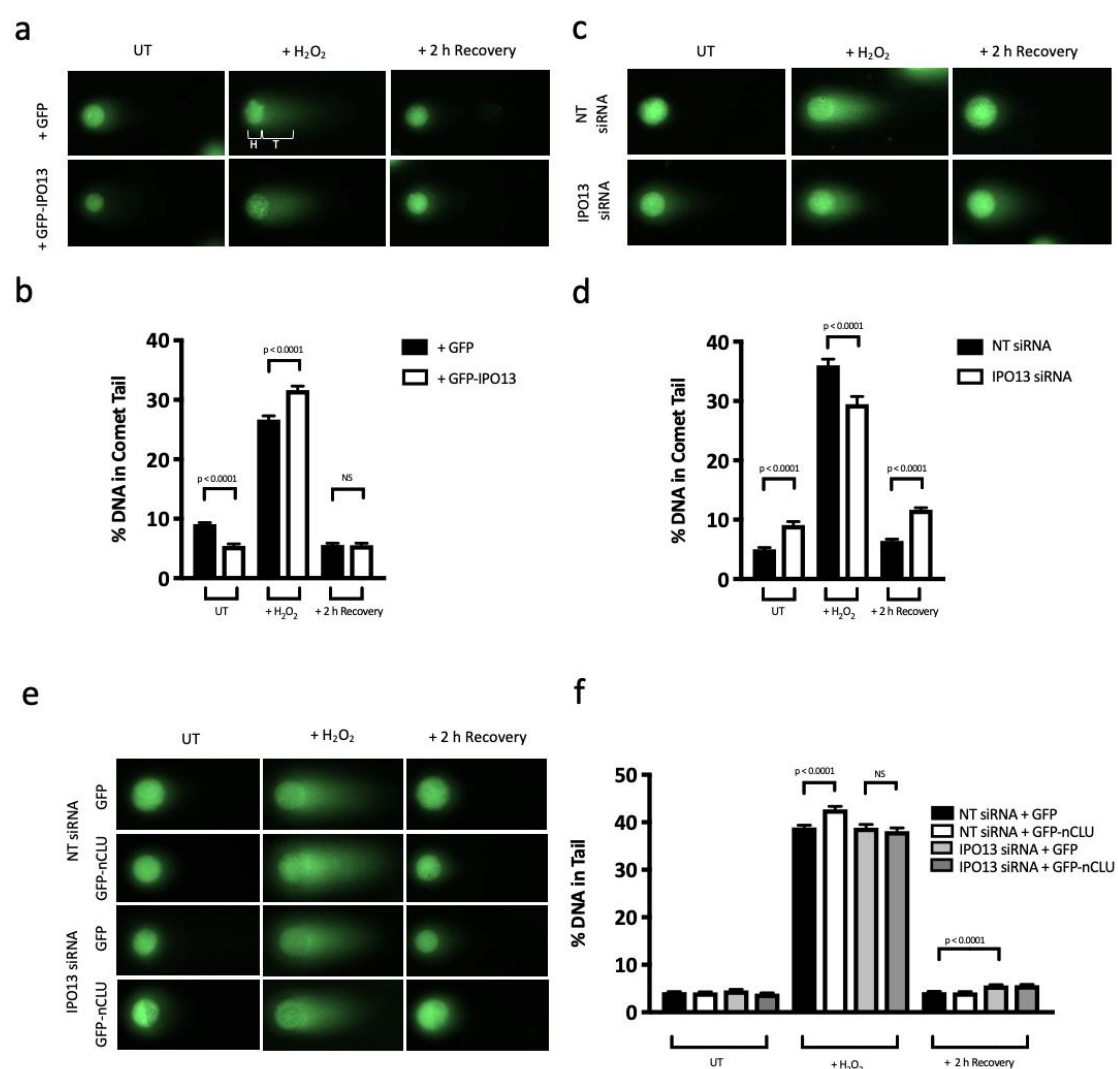
Figure 3. IPO13 plays a significant role in stress-induced DNA damage and repair, in part through effects on nCLU. ( a ) Fluorescence images of comets produced by in-gel neutral comet assay (single- cell electrophoresis) from HeLa cells ectopically expressing either GFP or GFP-tagged IPO13 after treatment without or with 50 µ M H 2 O 2 for 1 h or treatment followed by 2 h recovery in fresh media. H denotes the comet head and T denotes the comet tail (middle top panel). ( b ) Tail DNA content (%) was quantified using the OpenComet plugin for ImageJ to determine the percentage of DNA in the comet tail (mean ± SEM, n > 100 comets per sample). Results represent a single typical experiment from a series of 3 independent experiments. ( c ) Fluorescent images of comets produced as in ( a ) from HeLa cells transfected with either non-targeting (NT) or IPO13 siRNA after treatment as in ( a ) with 125 µ M of H 2 O 2 . ( d ) Tail DNA content of pictures, such as those in ( c ), was quantified as in ( b ). ( e ) Fluorescent images of comets produced as in ( a ) from HeLa cells transfected with either NT or IPO13 siRNA that ectopically expressed either GFP or GFP-nCLU after treatment as in ( a ) with 125 µ M H 2 O 2 . ( f ) Tail DNA content from images, such as those in ( e ), was quantified as in ( b ), with results representing a single typical experiment from 2 independent experiments (mean ± SEM, n > 200 comets per